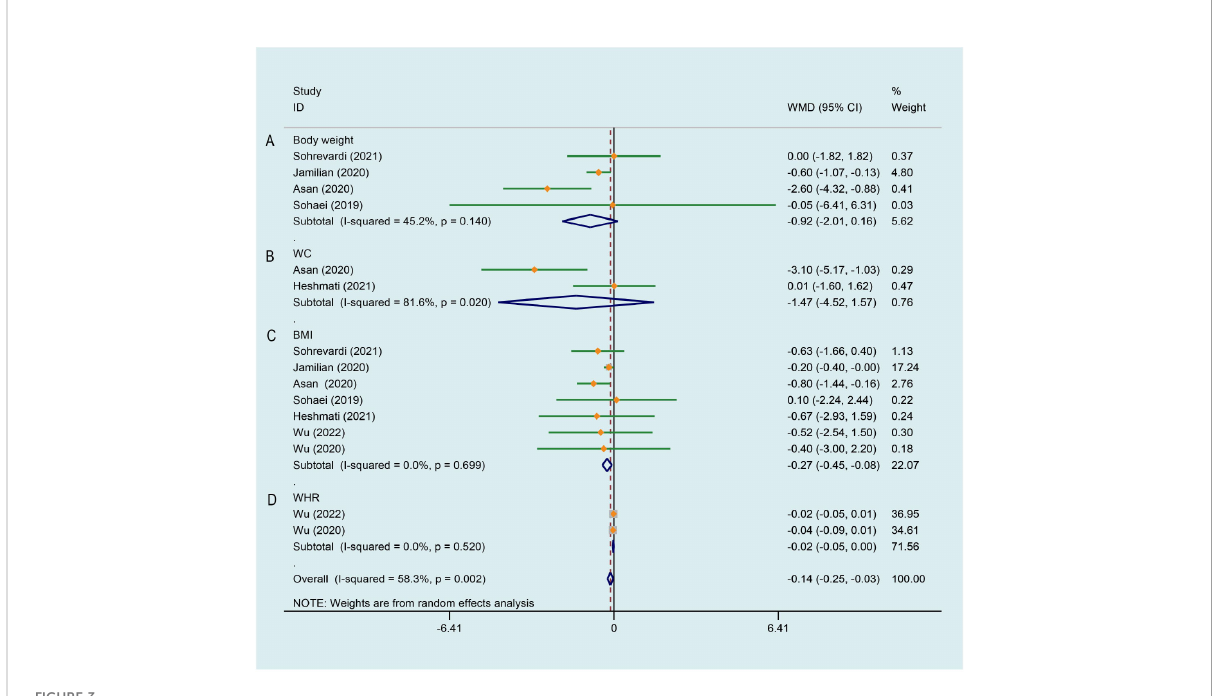
FIGURE 3 Meta-analyses of the effect of curcumin on anthropometric parameters. (A) Body weight, (B) WC, (C) BMI, (D)